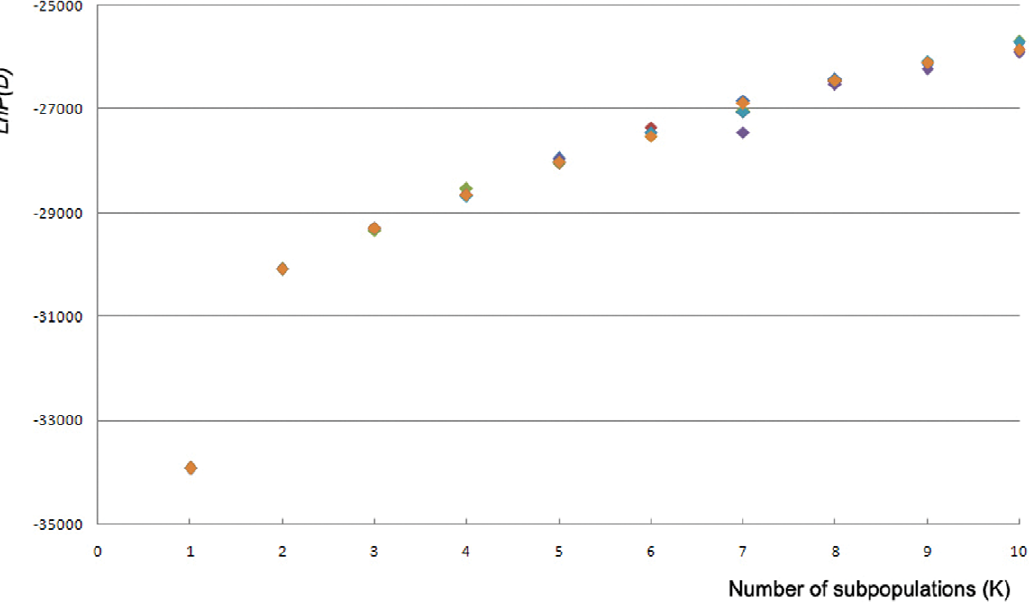
Figure 1. Posterior probabilities (Ln P (D)) from six parallel calculations for each hypothetic number of subpopulations (K) in the range of K=1 to